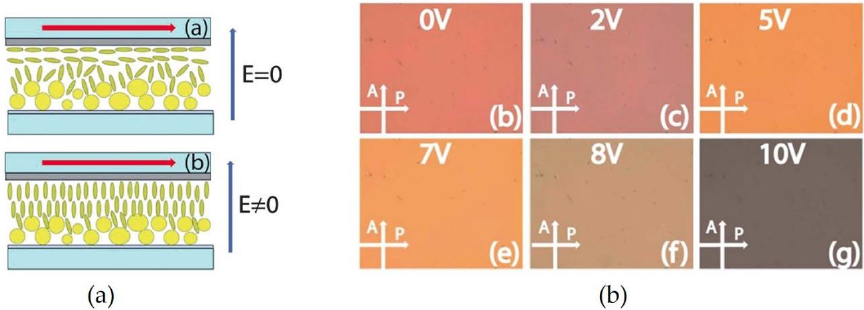
Figure 10. ( a ) Schemes for controlling the orientation of NLCs between glass/ITO substrates by an electric field; and ( b ) color of the substrates obtained by the field application at various field strengths: 0 to 10 V. Reproduced with permission from Reference [76] (Copyright 2012 The Royal Society of Chemistry).